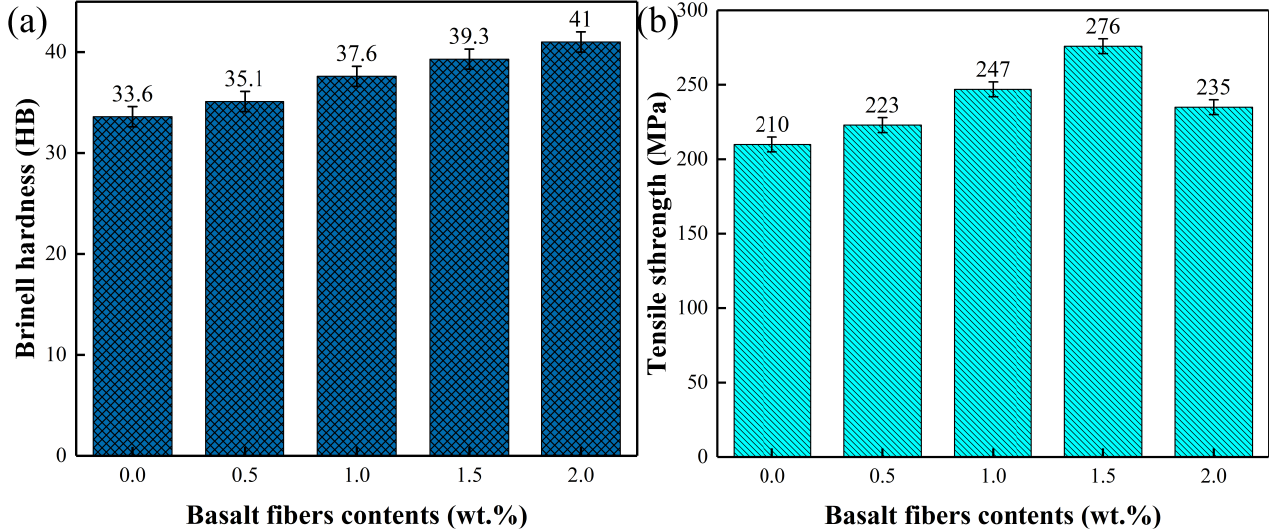
Figure 6. Hardness ( a ) and tensile strength ( b ) of composites prepared with different basalt fiber contents.